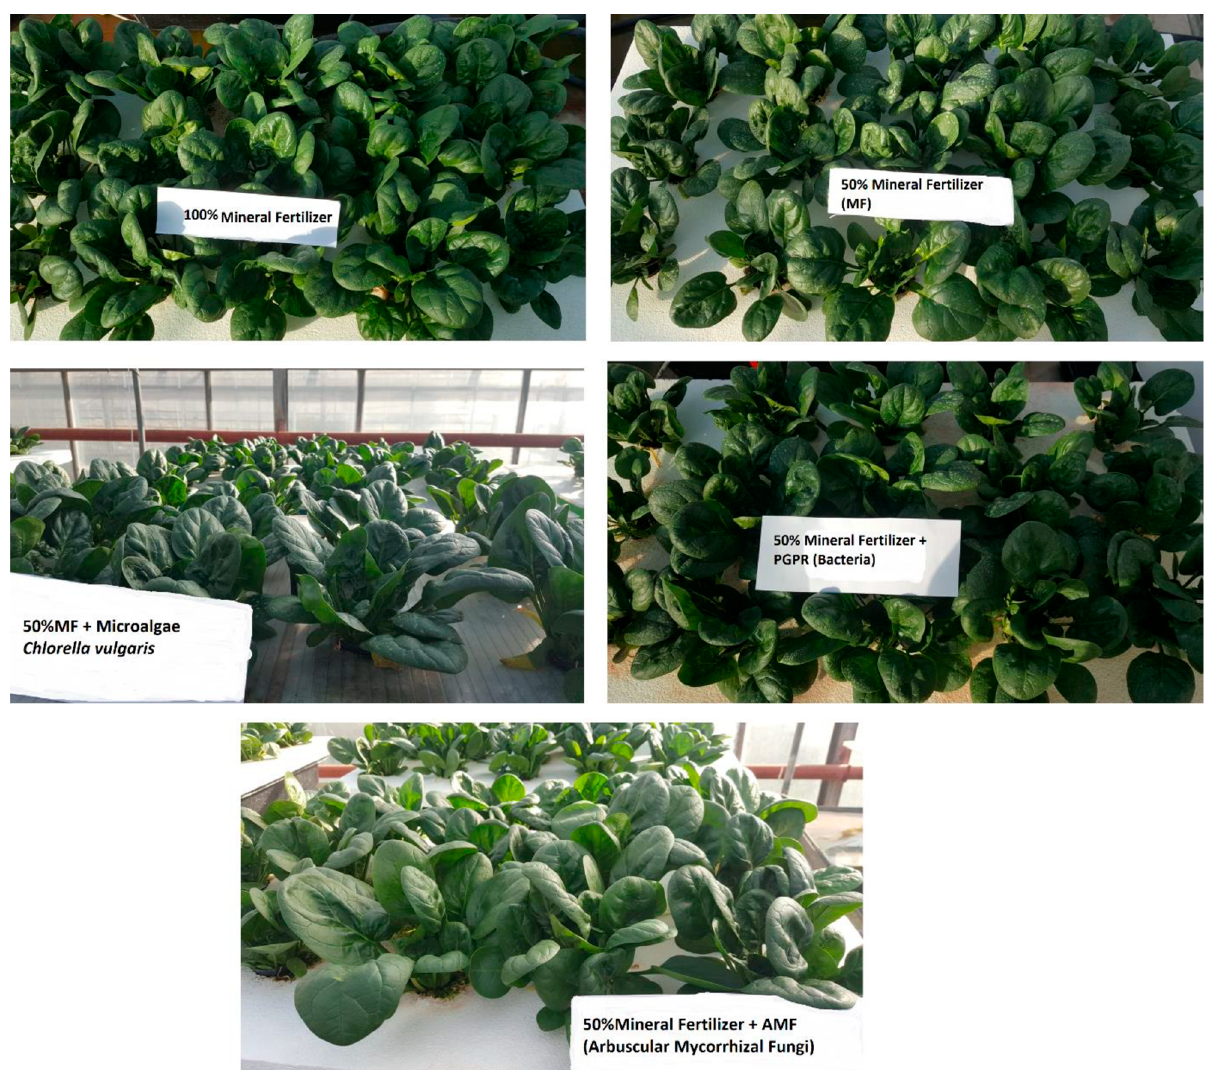
Figure 3. Images of baby spinach plants grown hydroponically with supplemented microalgae, PGPR, and AMF in comparison to 100% and 50% mineral fertilizers.